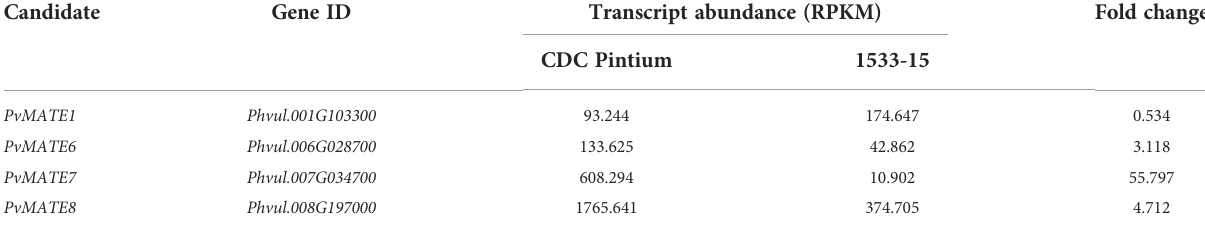
TABLE 1 Differential expression of candidate PvMATE s in pinto bean cultivars CDC Pintium and 1533-15 seed coat tissues (Duwadi et al., 2018).